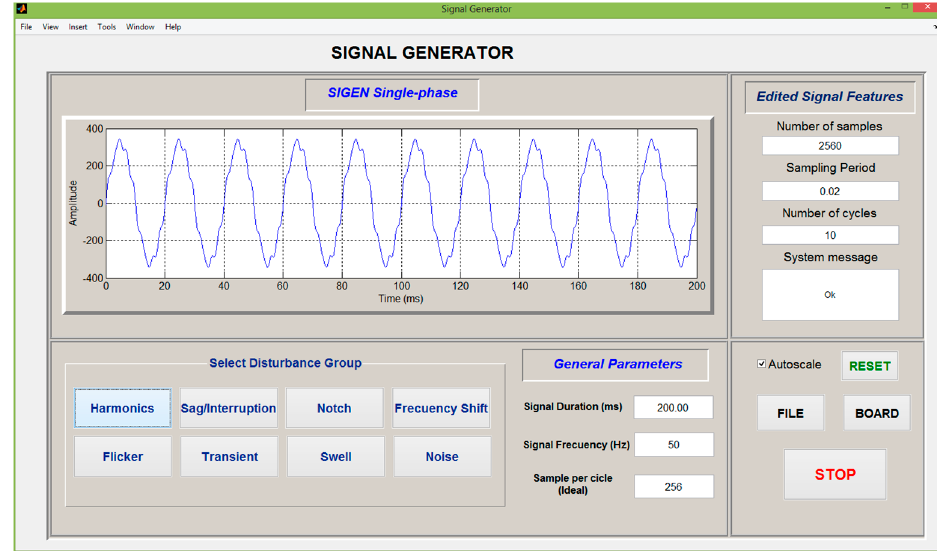
Figure 4. Graphical user interface of the Sigen system.